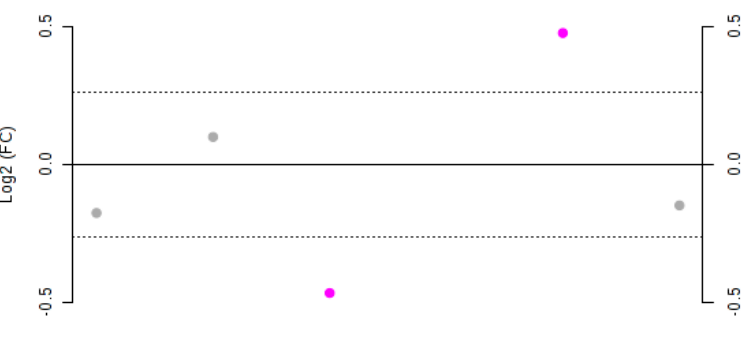
Figure 3. Fold-change (FC) plot of the Log2 values for Negroamaro and Primitivo wine samples. Dots represent, from left to right, gallic acid, catechin, hydroxytyrosol, syringic acid, trans -resveratrol, and quercetin. Values with a Log2(FC) > 1.2 are highlighted in purple.